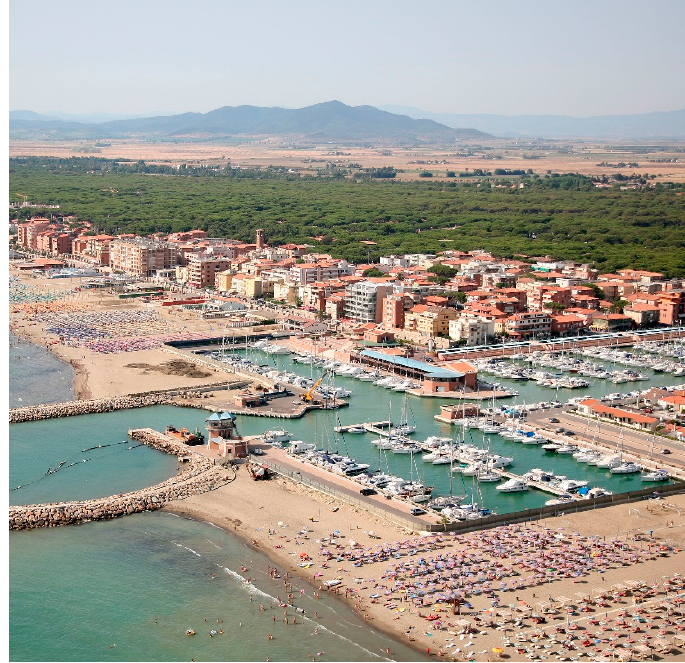
Figure 8. The boathouse at Marina di Grosseto, whose entrance is protected by two jetties. The updrift one intercepts the long shore sediment transport, creating an extensive beach.